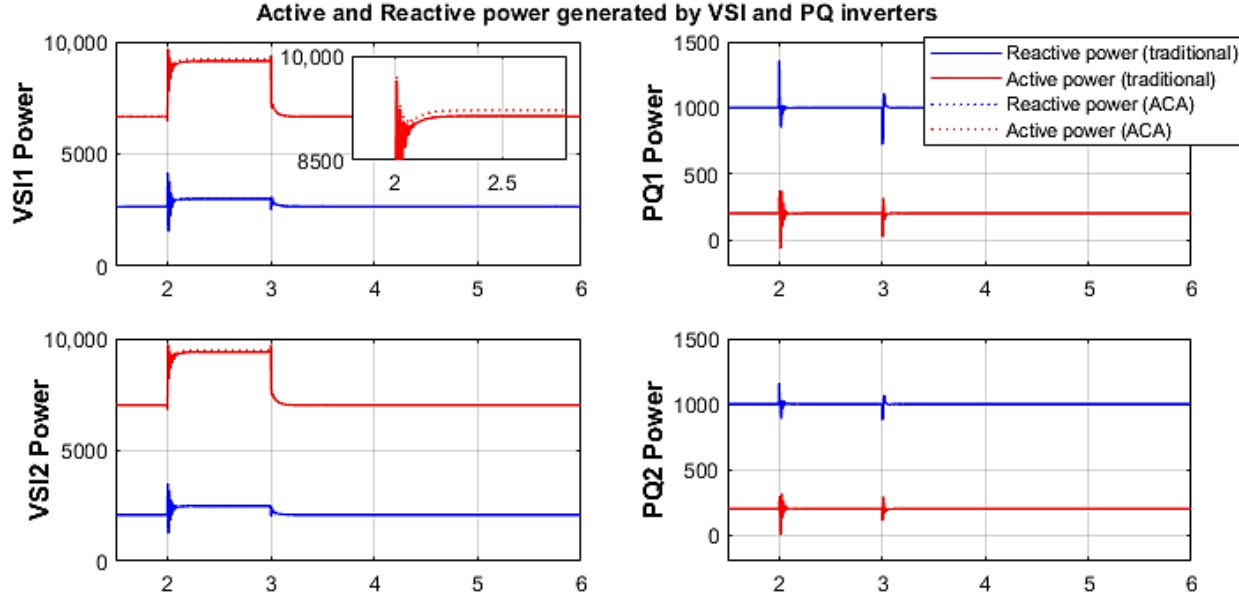
Figure 21. Voltage of Critical Buses with and without ACA after a Load Change at Bus 4.